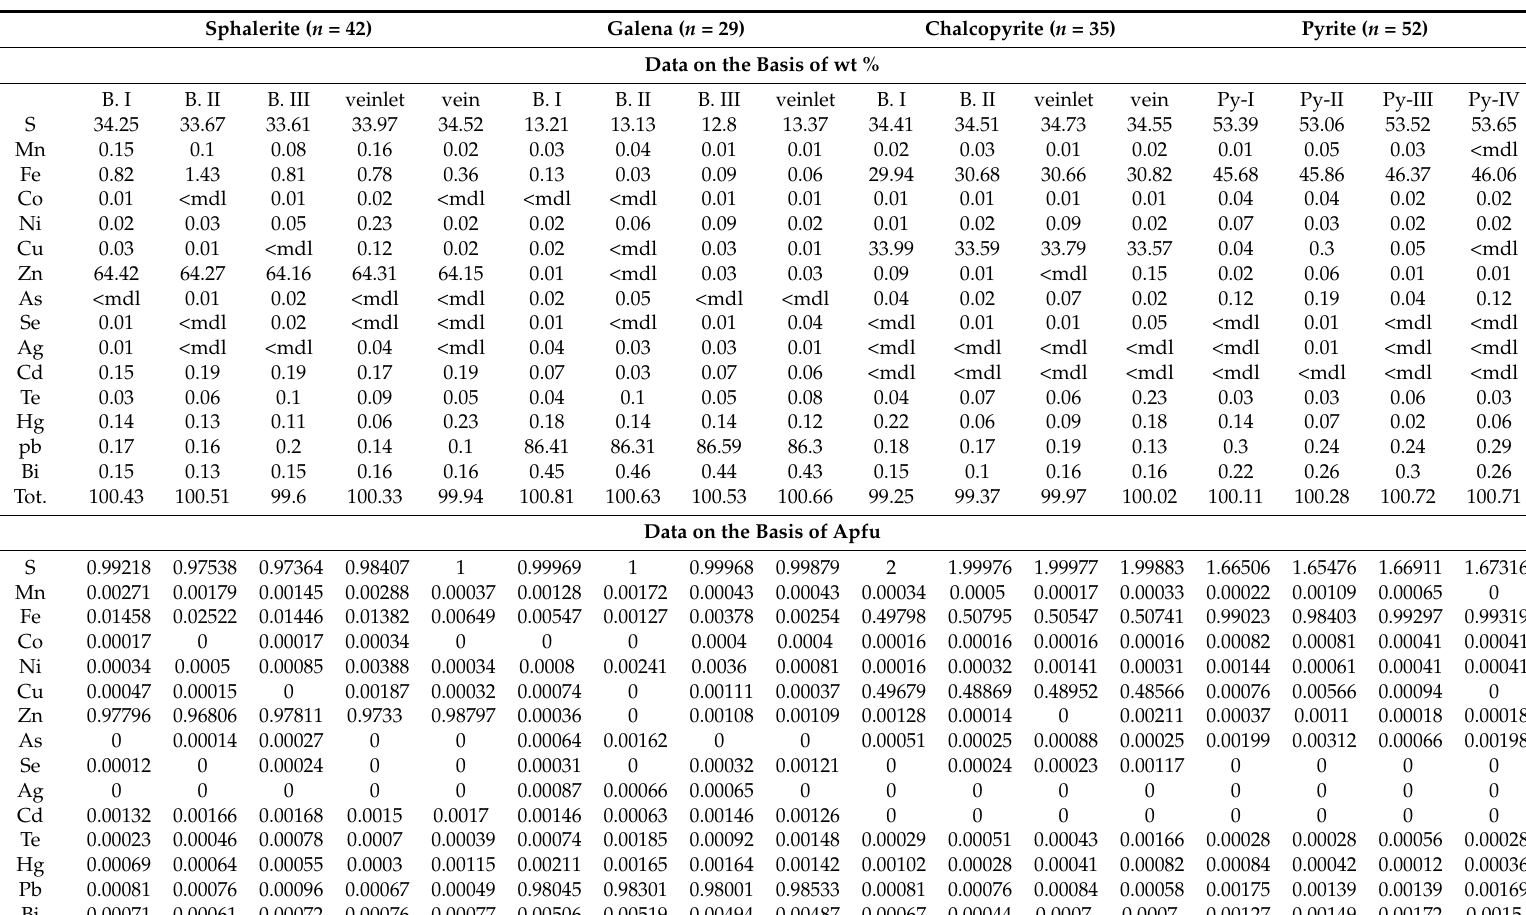
Table 3. Summary of average EPMA data for primary minerals from the Shah-Ali-Beiglou deposit (concentrations in wt %). B.I: Breccia I, V.I: sulfide-silica veinlets, and V.II: silica-sulfide-carbonate